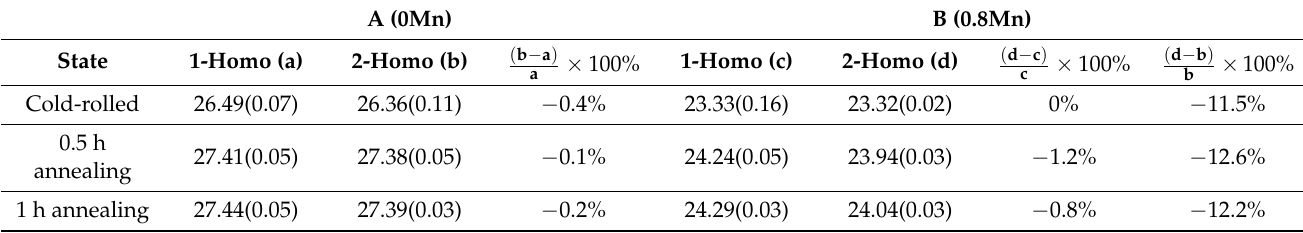
Table 1. A summary table of the measurement results of the conductivity (%IACS) of aluminum–magnesium alloys in various